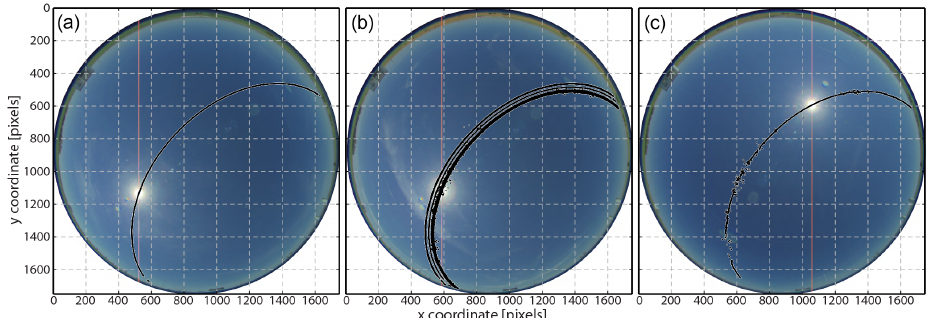
Figure 2. Solar position measurements on (a) 13 May 2013 (case 1); (b) three days in May and seven days in June 2013 with an image on 11 June 2013 (case 4); (c) 7 June 2013 (case 5). Measurements are overlaid on example images.